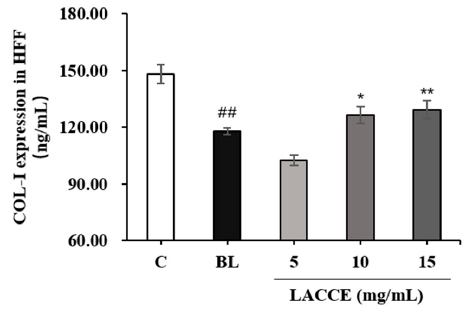
Figure 6. Effects of different concentrations of LACCE on COL-I. The data are expressed as mean ± standard deviation (SD) of three independent experiments ( n = 3). The data were analyzed using one-way analysis of variance (ANOVA) followed by Tukey’s test. ## p < 0.01 vs. control group (C). * p < 0.05 and ** p < 0.01 vs. blue light model group (BL).